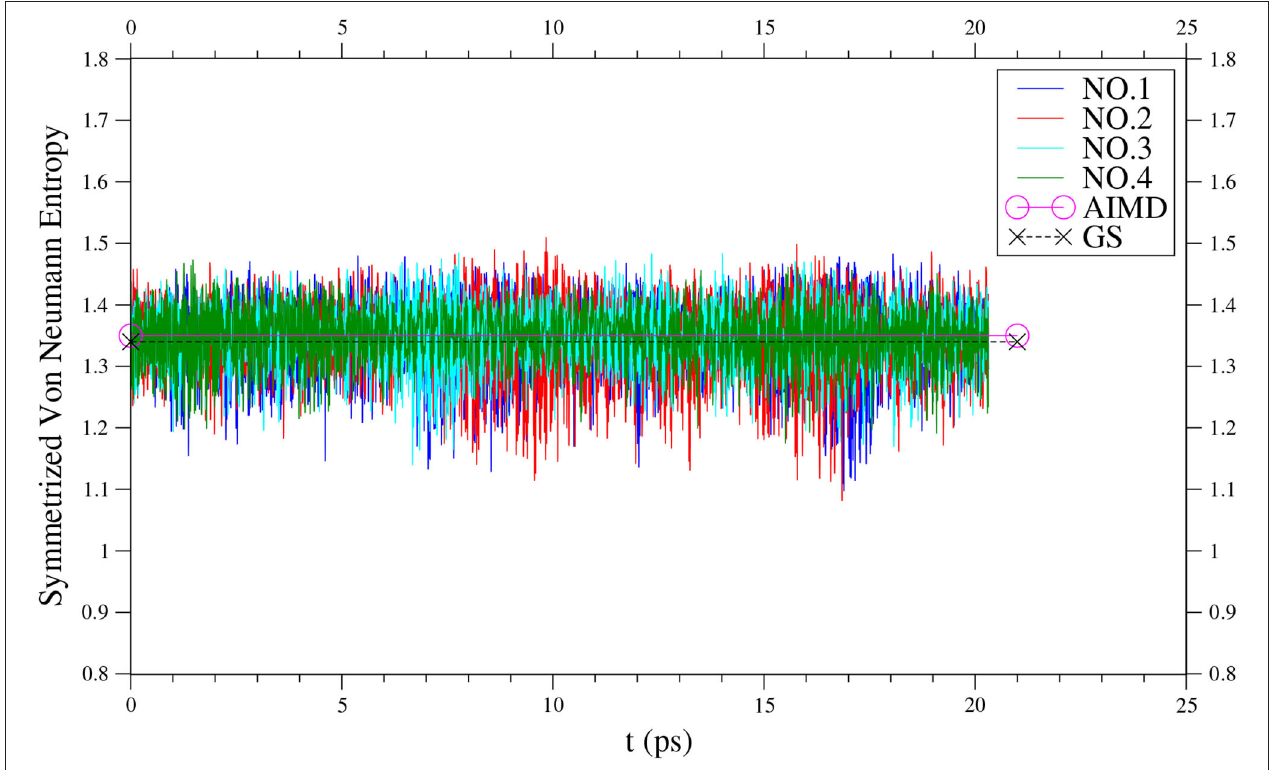
FIGURE 3 | Time evolution of the symmetrized von Neumann entropy of 8-acene, obtained from four different equilibrated TAO-AIMD trajectories (No.1 to No.4) at 300 K, calculated by TAO-LDA. The TAO-AIMD average and GS values are also shown for